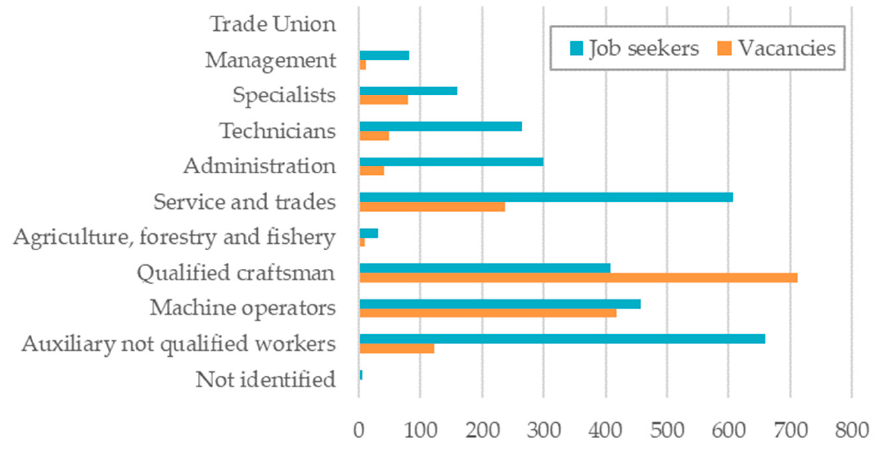
Figure 8. Number of unemployed and registered open positions in the Office of Employment, Social Affairs, and Family (2017).